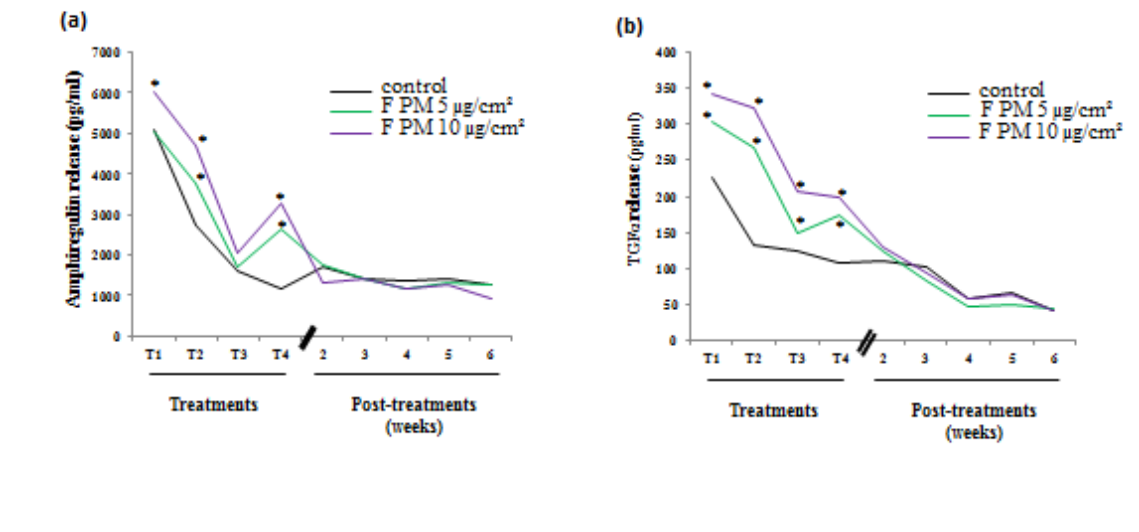
Figure 1. Release of growth factor by human bronchial epithelial (HBE) cells induced by particulate matter (PM) exposure. Cells were exposed or not four times (48 hours between treatments) to fine PM (F PM) at 5 and 10 µg/cm². Growth factor release was measured in the basal medium 48 hours after each treatment (treatments) and during five weeks following the end of treatments (post-treatments). ( a ) Amphiregulin release; ( b ) TGF- α release. *: Different from the control ( p < 0.05), n =